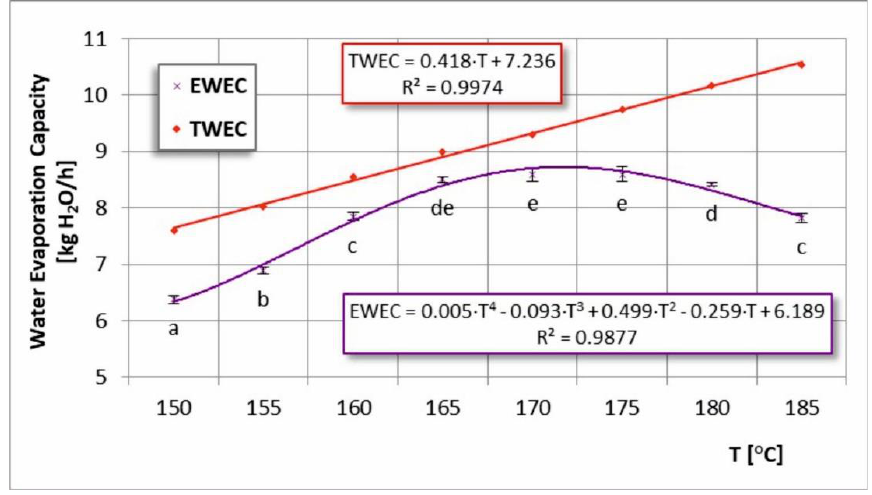
Figure 5. Total (TWEC) and effective water evaporation capacity (EWEC) in the process of spray drying chokeberry juice at different inlet air temperatures (T); (a, b, c, d, e — different letters show significant differences between mean values ( p ≤ 0.05)).